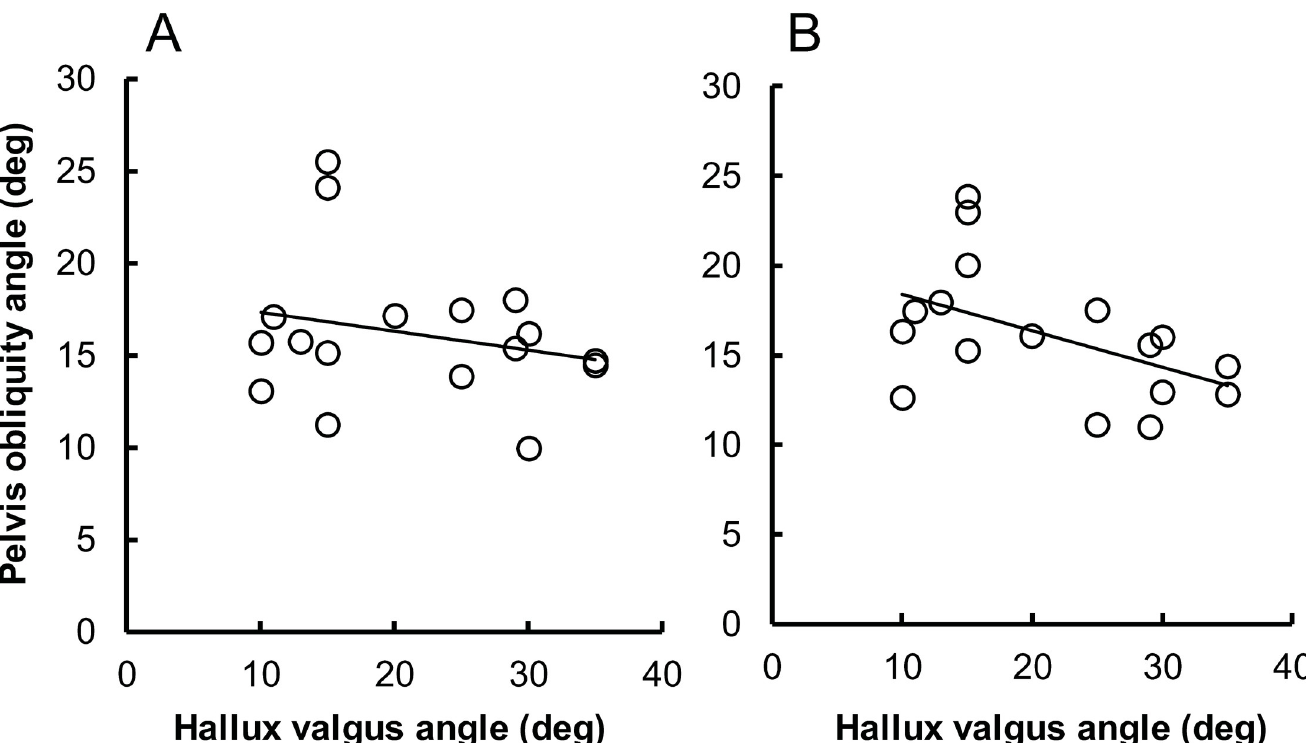
Fig 4. The scatter plot of the hallux valgus angle versus the pelvis obliquity angle. During (A) standing and (B) plie´ in the first position. The greater pelvis obliquity angle means anteversion. The Pearson product-moment correlation analysis revealed significant correlation between these variables only for plie´ ( r = -0.491, P = .045).